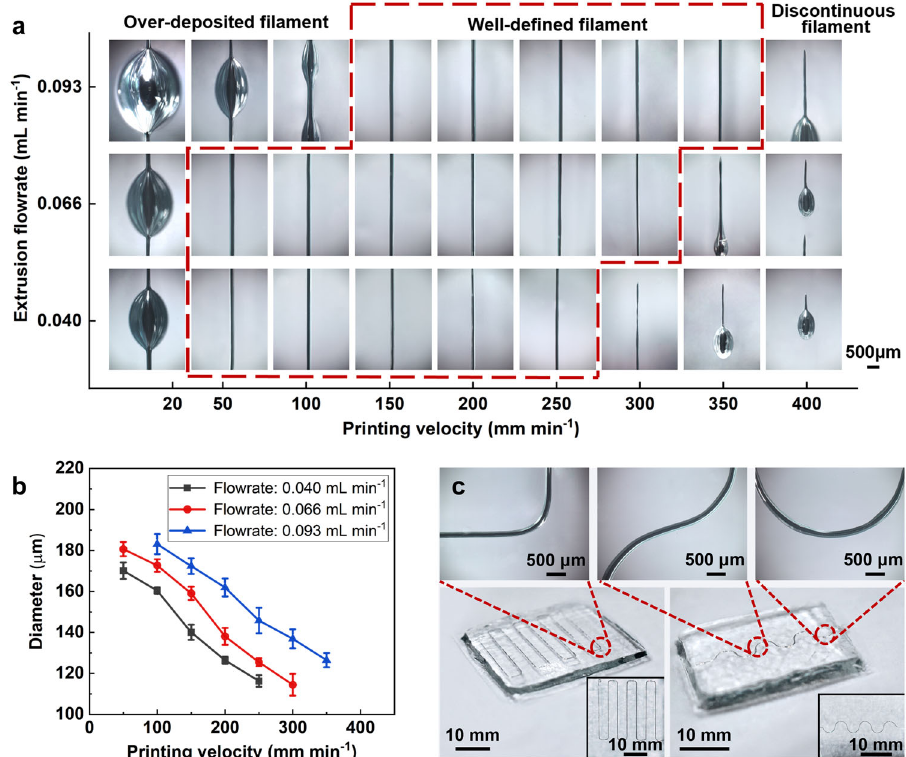
Fig. 2 The in fl uence of printing conditions on fi lament formation. a Optical microscope images of liquid metal fi laments resulted from different combinations of printing conditions. b Effects of printing velocity and extrusion fl owrate on the resultant fi lament diameter. The error bars represent the standard deviation (s.d.). c Photographs and optical microscope images of representative printed patterns of liquid metal in the support bath. Inset: top-view